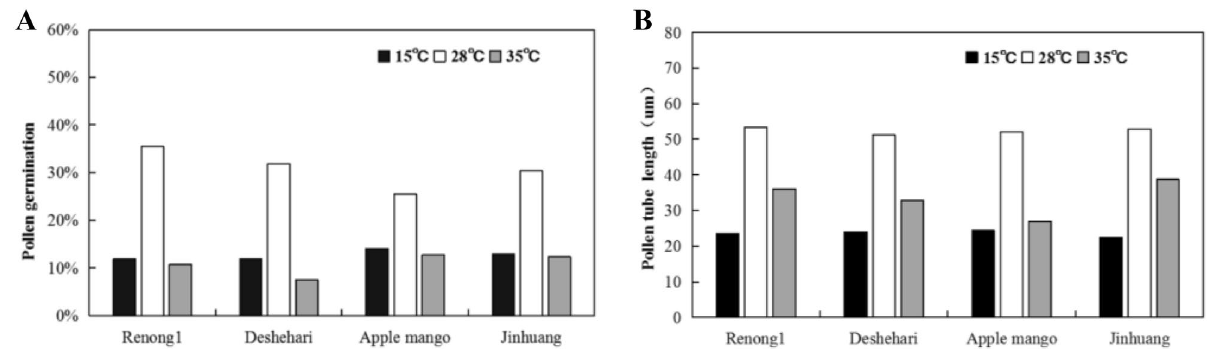
Figure 6. Germination rates ( A ) and pollen tube length ( B ) of pollen grains of four mango varieties at three different temperature conditions (15 °C, 28 °C and 35 °C).